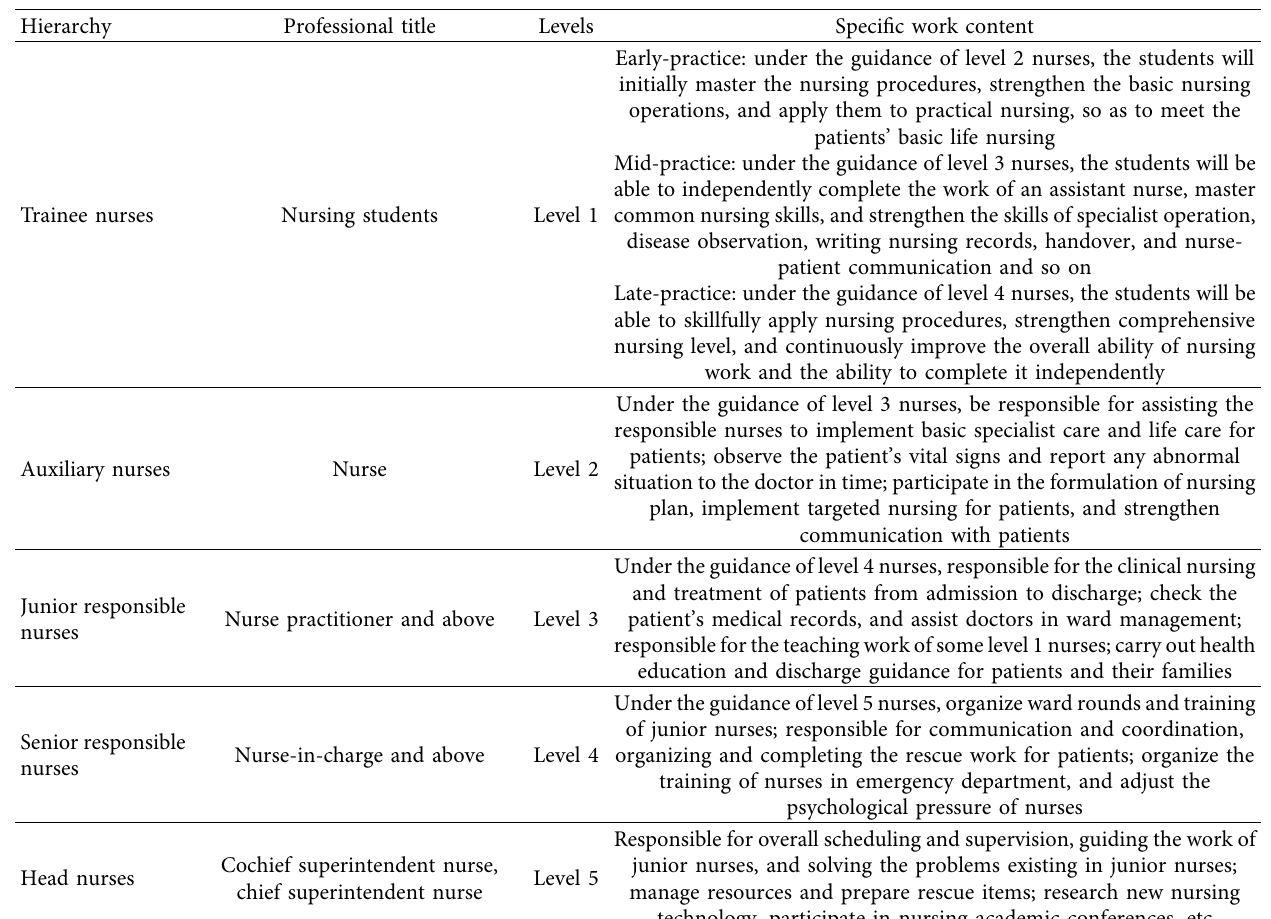
Table 1: Specific responsibilities of nurses at all